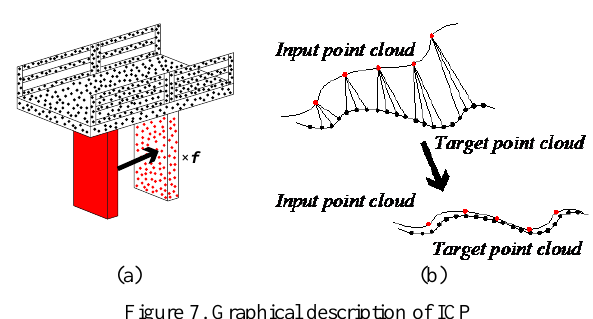
Figure 6. Result of decomposition.